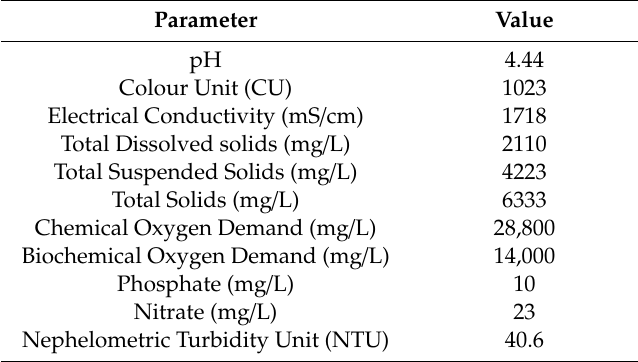
Table 1. Characteristics of the raw co ff ee pulping